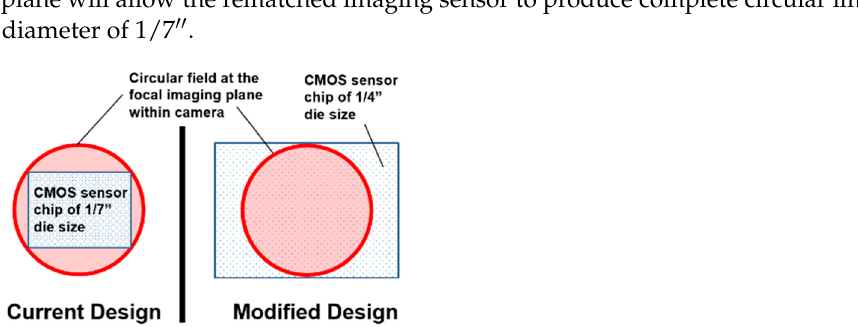
Figure 4. The current ( left ) and proposed ( right ) designs to acquire circular images using rectangular image sensor chips of different sizes.